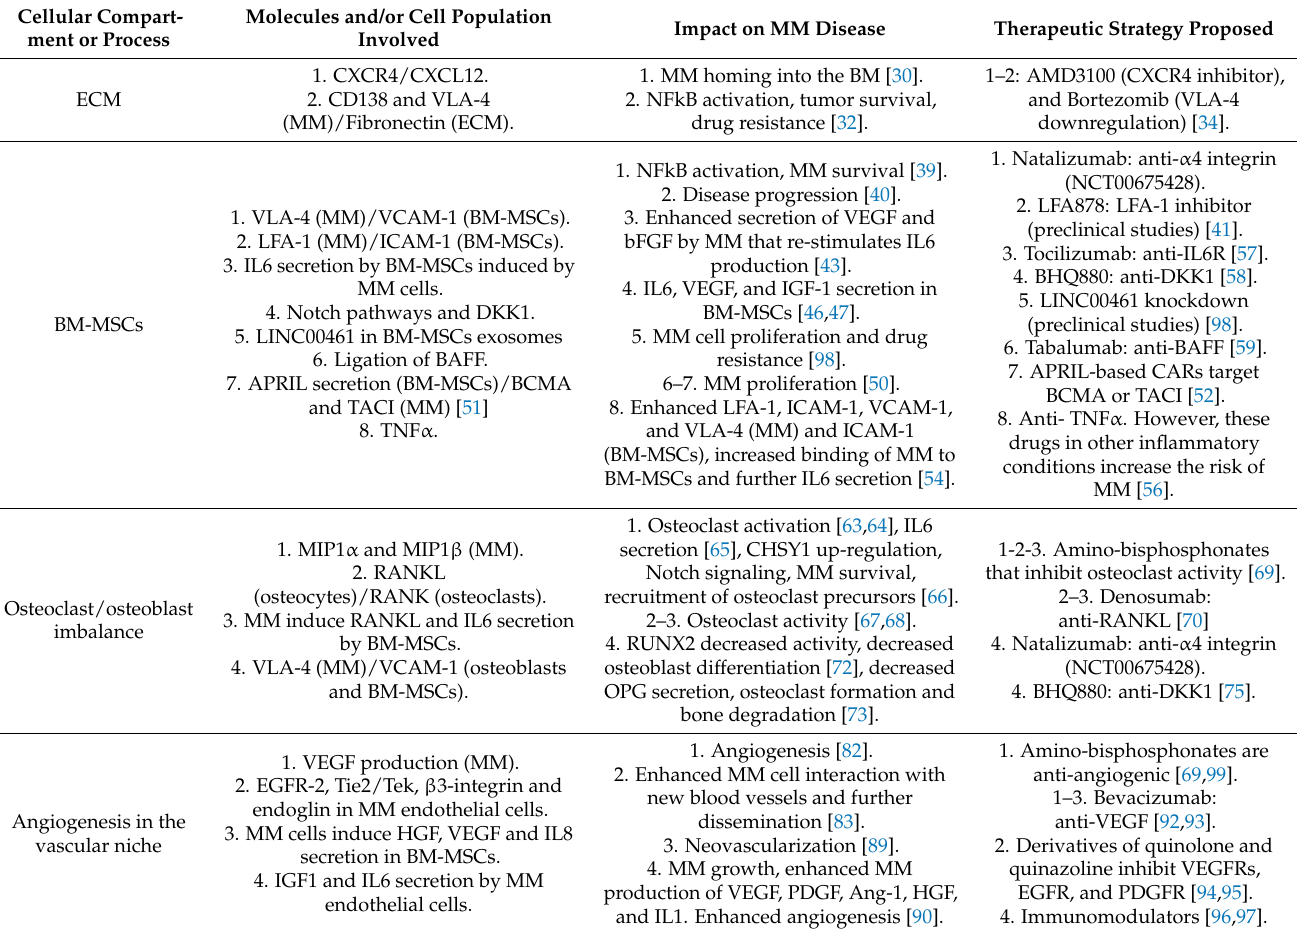
Table 1. MM the cell–cell interactions and molecules involved in the interactions that may affect disease progression and the anti-MM therapies that could target these interactions. Impact on MM Disease Therapeutic Strategy